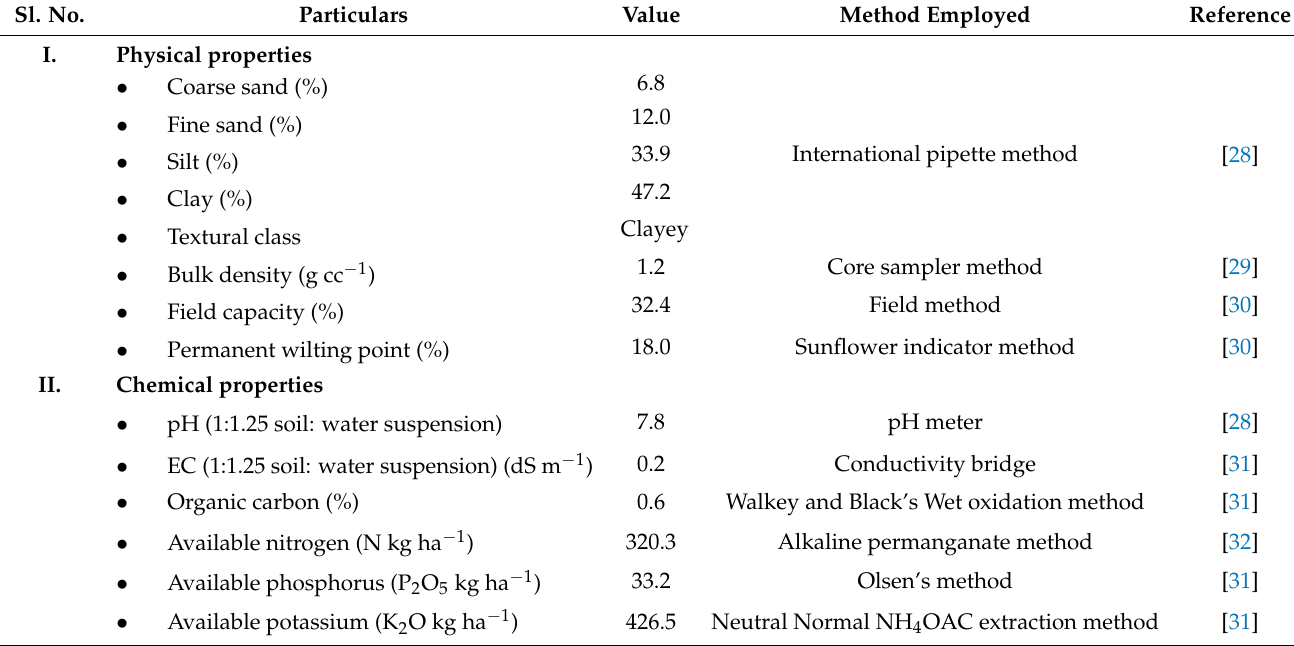
Table 1. Soil physical and chemical properties for the experimental